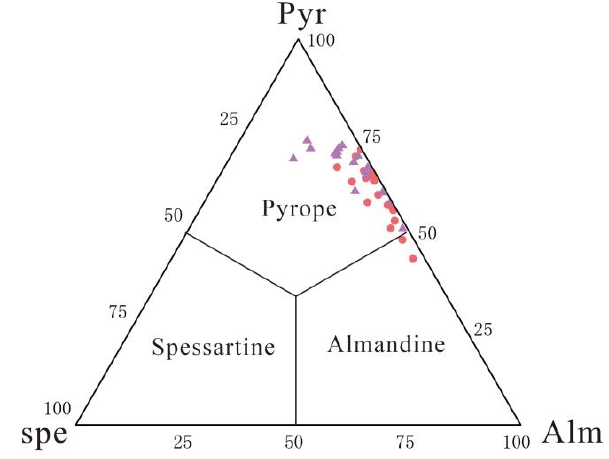
Figure 3. Pyralspite series classification based on the cation proportions of the X position. The red dots represent the red samples. The purple triangles show the characters of purple ones.